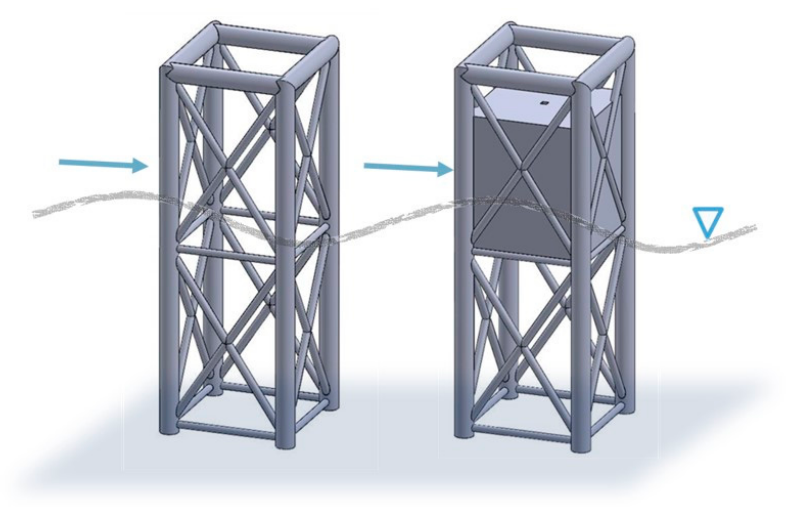
Figure 1. Schematic drawing of a jacket-type structure installed with oscillating water column (OWC) converter.